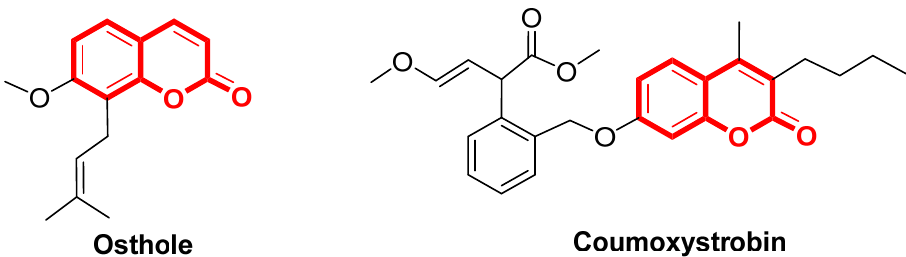
Figure 1. Structures of Osthole and Coumoxystrobin.